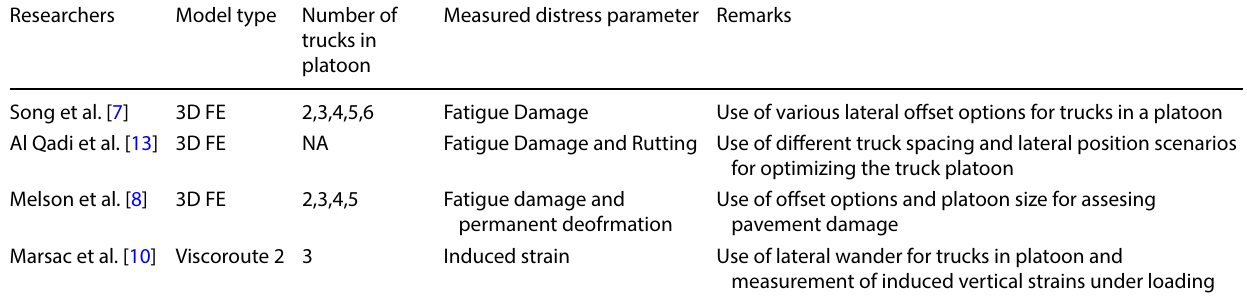
Table 1 Summary of research on truck platoons